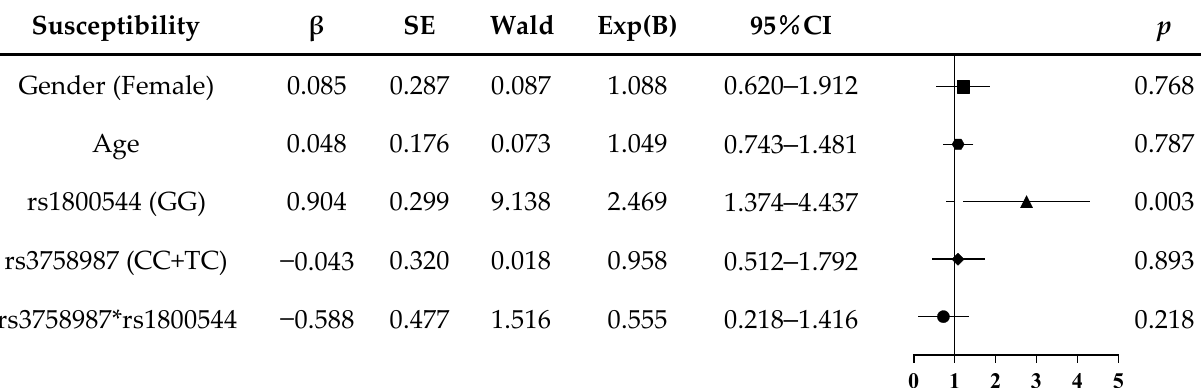
Figure 2. Logistic regression analysis of risk of motion sickness induced-vomiting in subjects. 3.5. Demographic Characteristic and Genotype Frequency of Subjects in Actual Voyages In part two, we recruited another 42 subjects for the two separate actual-voyage ex- periments, 27 for the first voyage and 15 for the second voyage. Among them, 11 subjects (26.2%) were carrying GG, 30 (71.4%) were carrying GC, and 1 (2.4%) was carrying the CC genotype in ADRA2A rs1800544. For rs3758987, there were 26 subjects (61.9%) carrying TT, 14 (33.3%) for TC, and 2 (4.8%) for the CC genotype. The constituent ratios of the sub- jects had no significant difference between parts one and two, and the frequencies of the SNPs conformed with the Hardy–Weinberg equilibrium law. Given that all the subjects had no sailing experience, and the sea state degrees were not significantly different during the first 24 h between the two voyages, the data obtained on day two were pooled for further analysis. Nearly 93% of the subjects had some level of seasickness symptoms within 24 h, and 16 subjects vomited and were defined as the vomited group. The fre- quency of the rs3758987 CC+TC genotype was significantly higher in the vomited group (62.5%) than in the non-vomited group (23.1%; p = 0.010). Furthermore, the distribution frequency of the rs1800544 GG genotype was higher in the vomited group (31.3%) than in the non-vomited group (23.1%), but not significantly ( p = 0.56). 3.6. Basic Expression ADRA2A and HTR3B mRNA in Different Genotype Carriers We investigated the influence of exposure to sailing at sea on the ADRA2A and HTR3B mRNA level changes in the subjects with each type of genotype for the examined SNPs (rs1800544 and rs3758987). We collected the blood samples of all 42 subjects seven days before their sailing and found that the basic ADRA2A mRNA level was significantly lower in the rs1800544 GG carriers than in the GC and CC carriers ( p < 0.05; Figure 3A). Furthermore, for the HTR3B mRNA, its basic level of rs3758987 TT carriers was signifi- cantly higher than that of the TC and CC carriers ( p < 0.05; Figure 3C). Within the first 24